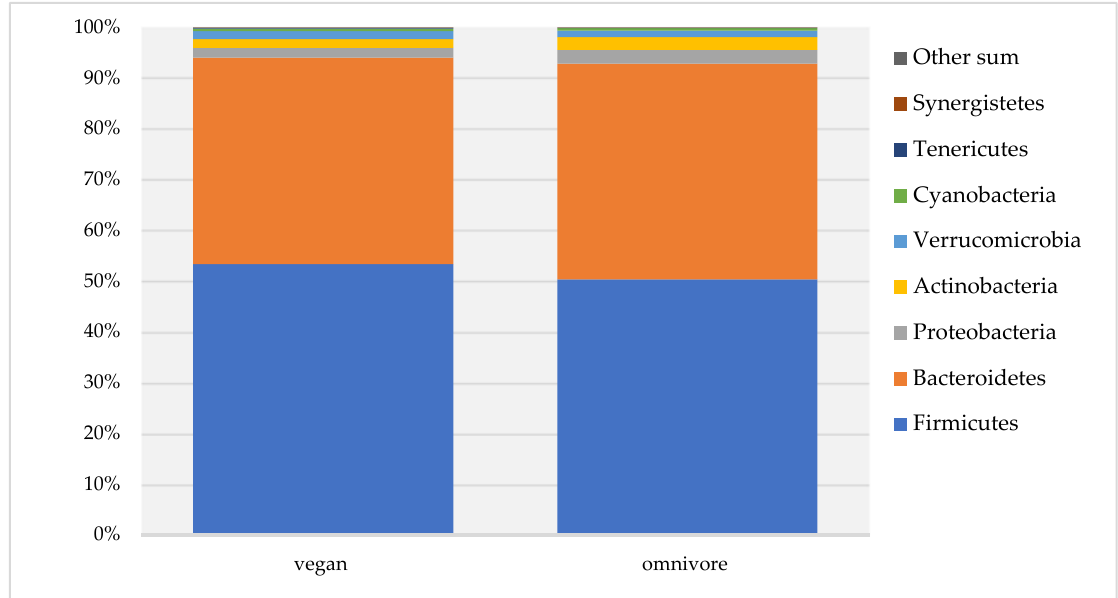
Figure 3. Gut microbiota composition at phylum level in RBVD.